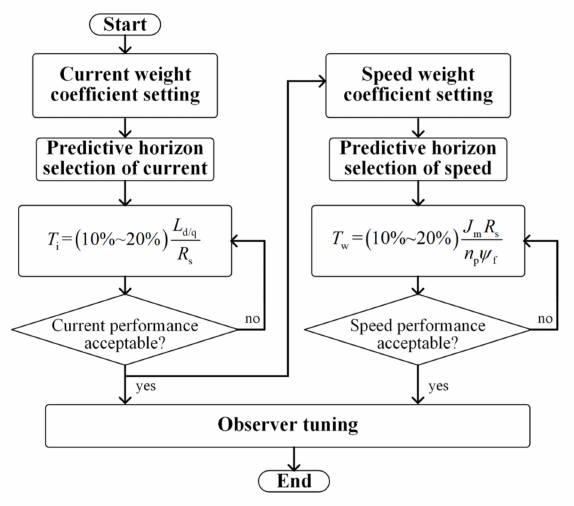
Figure 2. Parameter tuning flowchart of the proposed